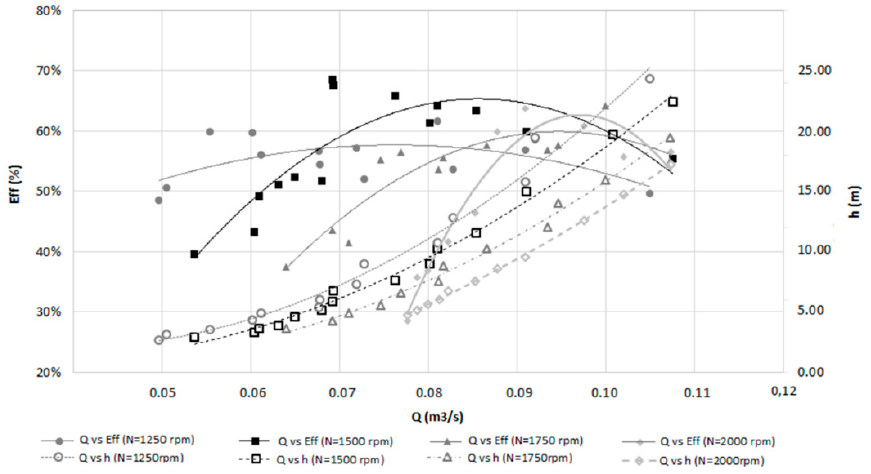
Figure 7. New predicted efficiencies and head for D = 170 mm obtained by the new proposed affinity laws.